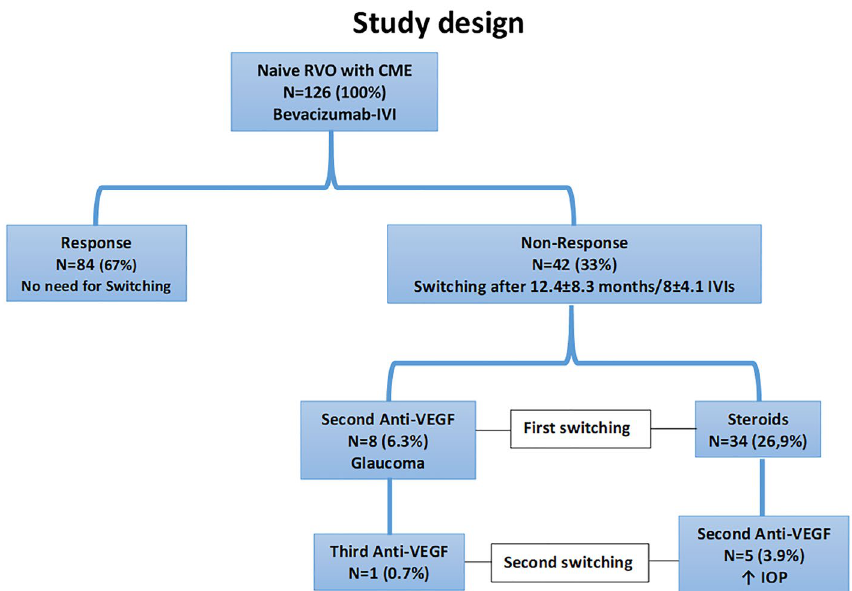
Figure 2. An overview of our study design and the therapy course: a total of 126 eyes were included in the study and received intravitreal Bevacizumab: 84 eyes continued to receive intravitreal bevacizumab for the entire follow-up duration ( group 1 ), therapy with intravitreal bevacizumab had to be switched to another agent in 42 eyes due to non-response ( group 2 ). While 14 eyes showed an early non-response at the end of the upload phase ( subgroup a ), late non-response occurred in 28 eyes ( subgroup b ). This first switching was to steroids in 34 eyes and to a second anti-VEGF agent in 8 eyes because of a pre-diagnosed glaucoma. A second switching occurred because of a renewed non-response from the second to a third anti-VEGF agent in one eye and from steroids to a second anti-VEGF agent in 5 eyes because of steroid response. RVO retinal vein occlusion, CME cystoid macular edema, IVI intravitreal injection, anti-VEGF anti vascular endothelial growth factor, IOP intraocular